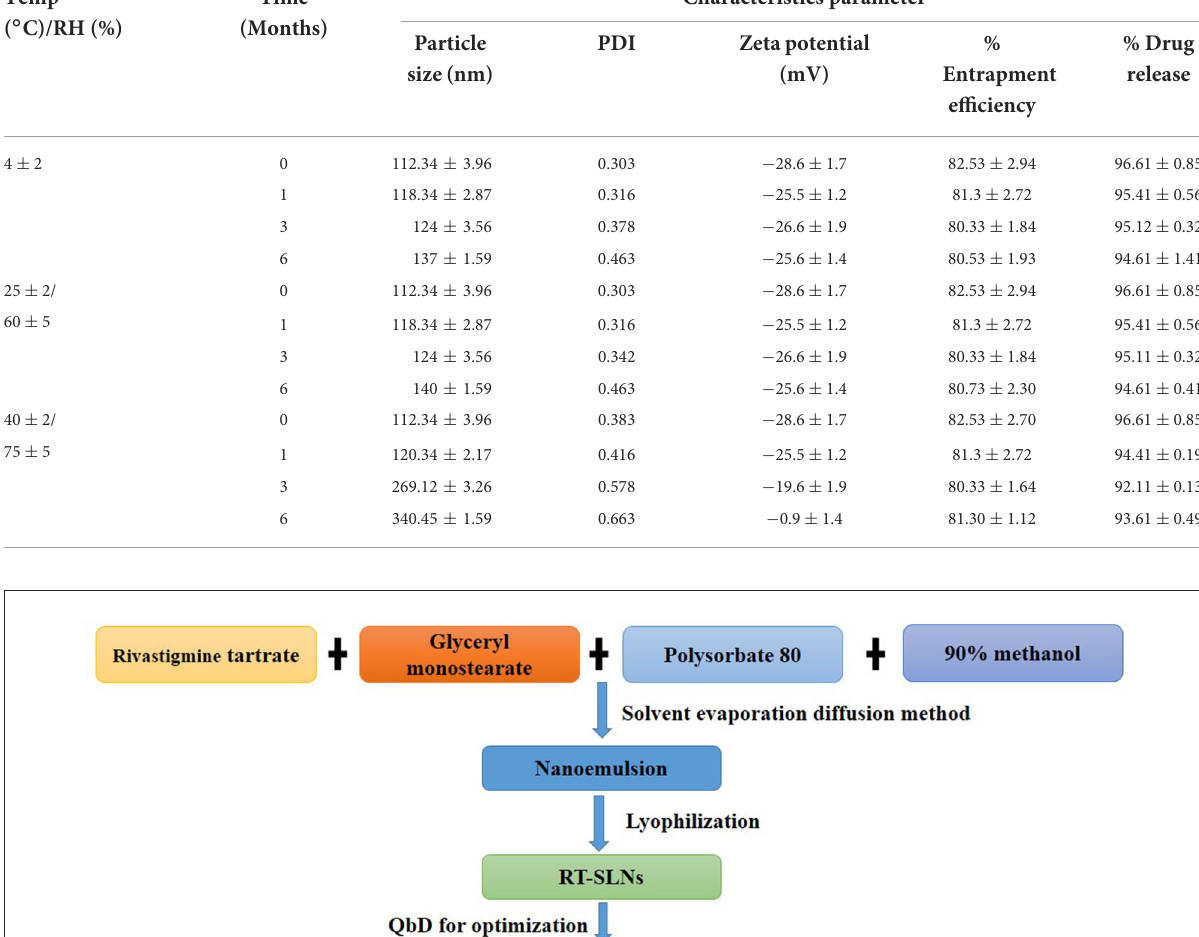
Characteristics parameter